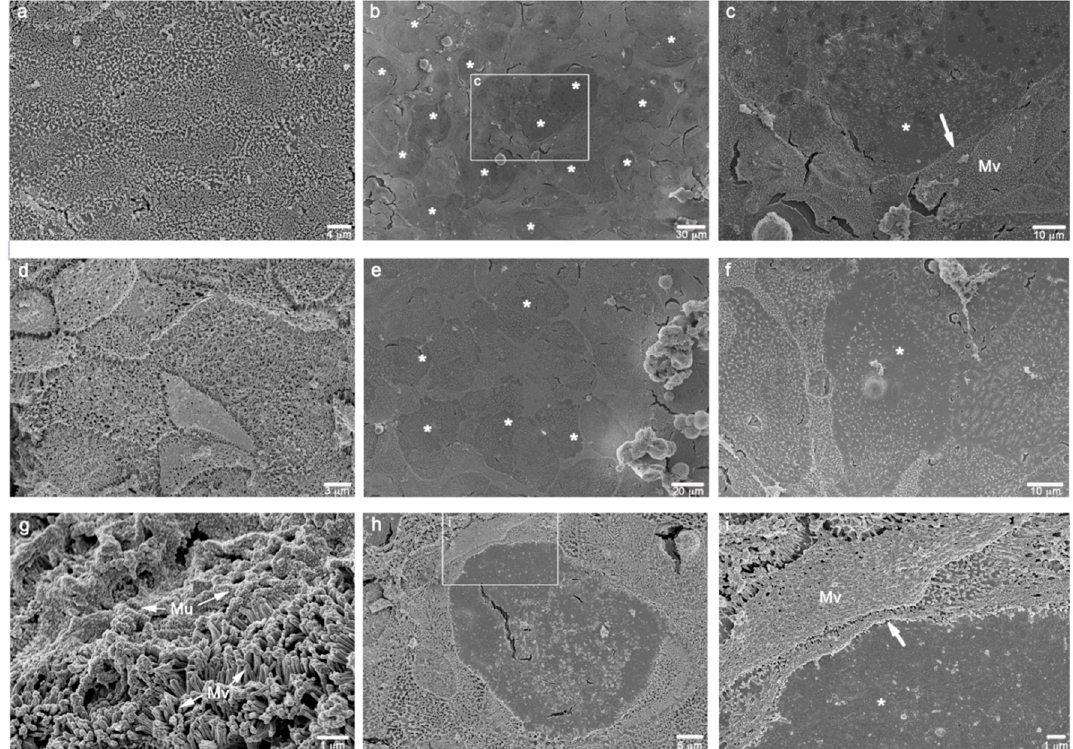
Figure 3. SEM micrographs of the different combinations of cell cultures grown on inserts, at 21st day of culture. ( a ): Caco-2 monoculture showing a homogeneous leaflet of polarized epithelial cells with a great abundance of surface microvilli. ( b ): Caco-2/Raji B co-culture displaying some rounded areas of microvilli loss. ( c ): high magnification of the squared area in b showing the boundary (white arrow) between presence (Mv) and absence (*) of the surface microvilli. ( d ): Caco-2/HT29-MTX differentiated co-culture rich in surface microvilli. ( e,f ): Caco-2/HT29-MTX/Raji B tri-culture showing a lot of inducted smooth rounded areas of possible M-cell phenotype (*). ( g ): Caco-2/HT29-MTX co-culture displaying a consistent mucus layer (Mu) on the microvilli. ( h, i): high magnifications of a feasible M-cell phenotype (*) in Caco-2/HT29-MTX/Raji B tri-culture (white arrow: boundary of the microvilli loss.